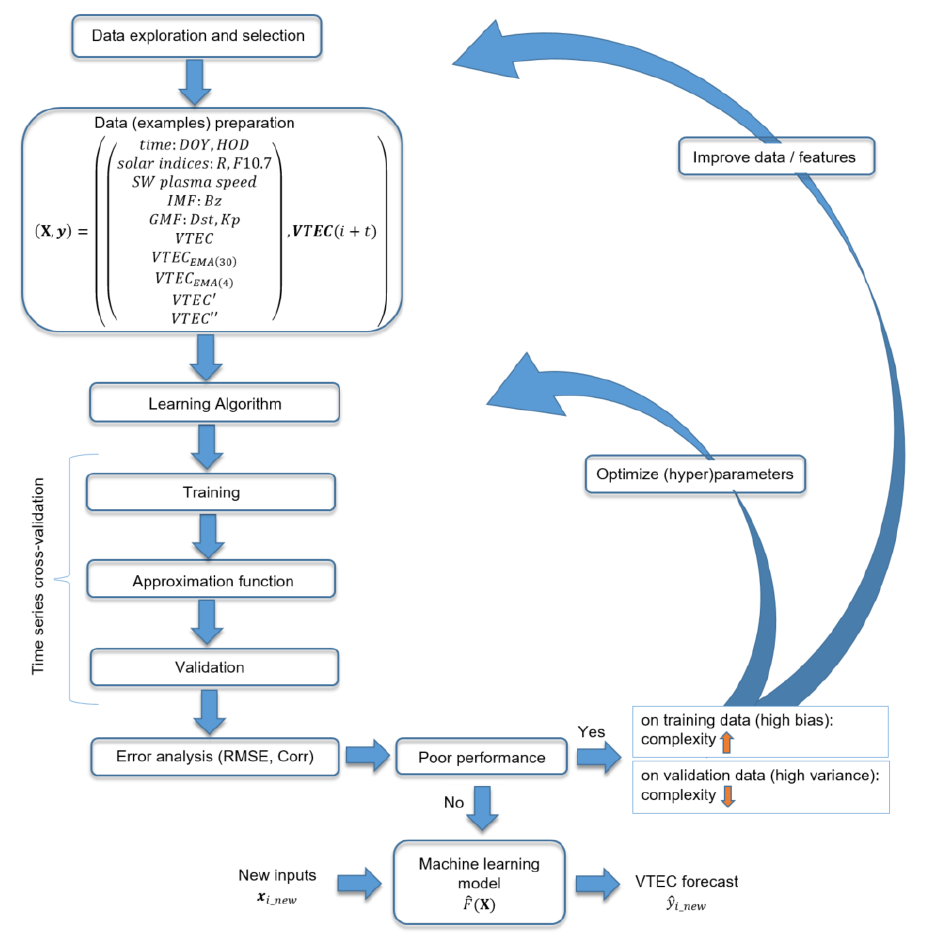
Figure 4. Flowchart of VTEC machine learning model development from data exploration, selection, and preparation to training and cross-validation until the final machine learning model with the target approximation function is not found. The model is optimized in terms of its performance. Poor performance on training and validation data is the result of high bias, while poor performance on validation data is the result of high variance. They can be solved by increasing or decreasing the model complexity, respectively. The final machine learning model can be used to forecast VTEC on new input